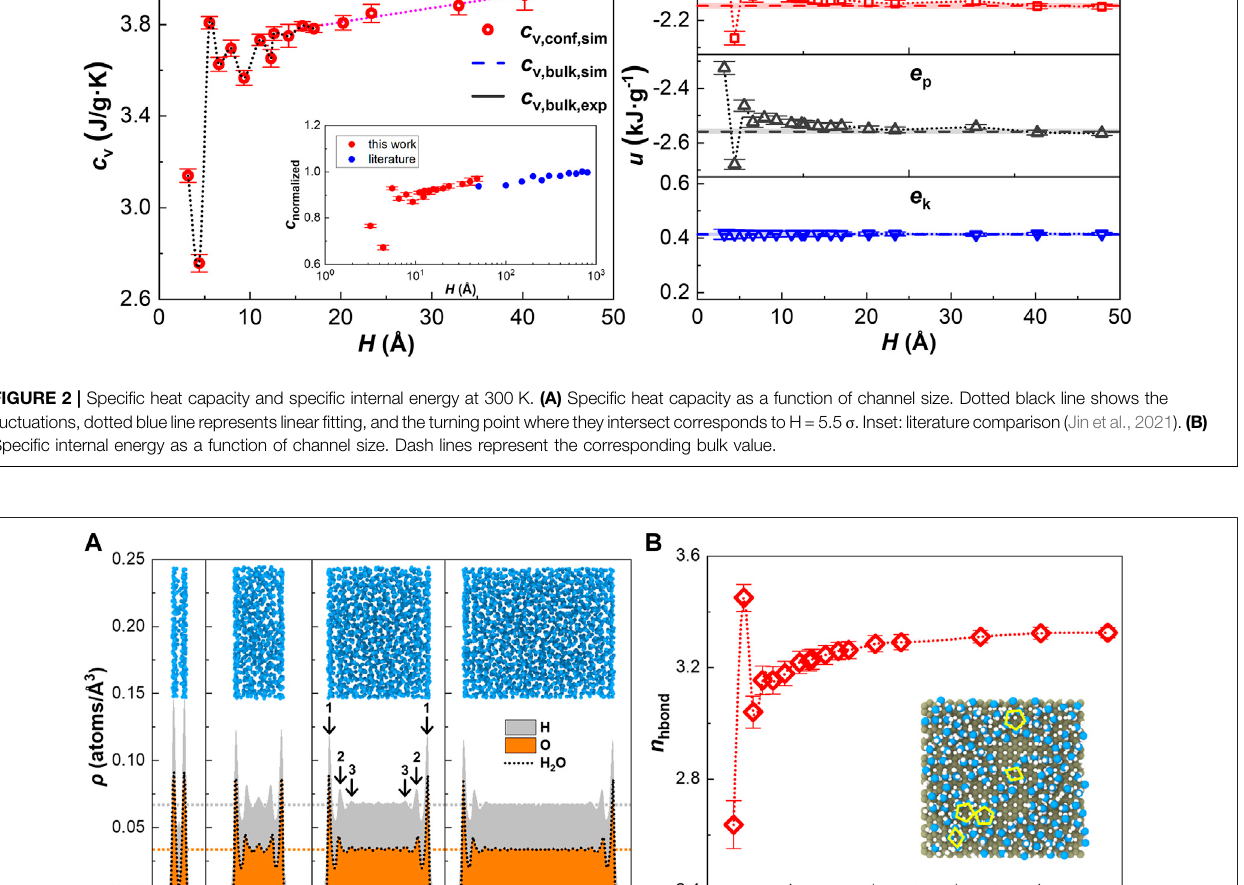
Frontiers in Energy Research |